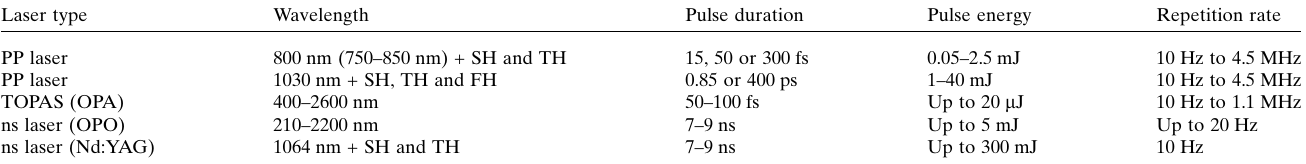
Table 1 Available optical laser parameters at SPB/SFX. For the PP laser, the repetition rate is the intra-burst repetition rate; the pulse energy depends on this repetition rate setting. SH – second harmonic. TH – third harmonic. FH – fourth harmonic.